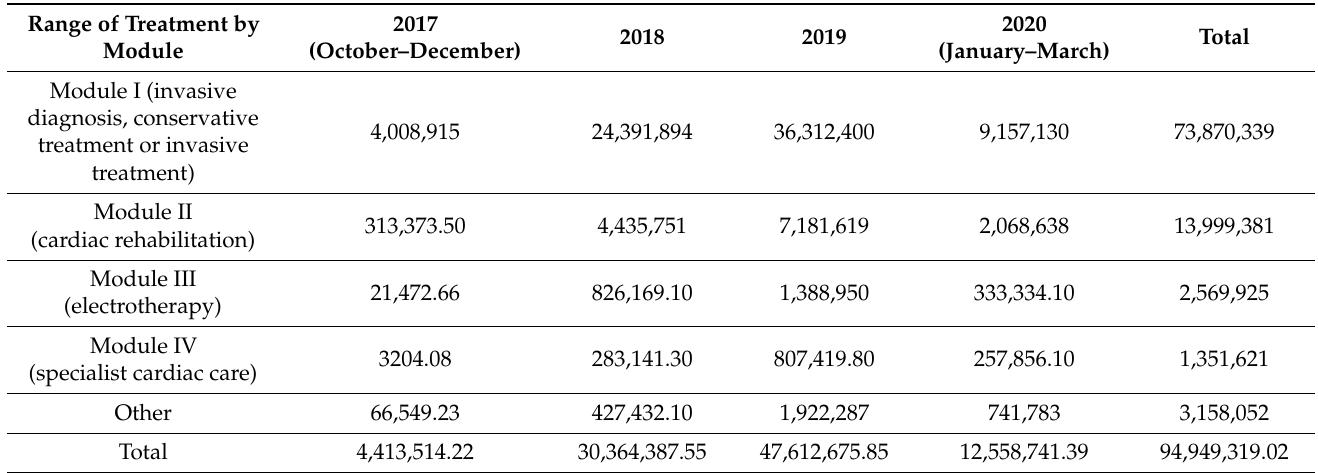
Table 3. Total costs of treatment (in EUR) of patients covered by CCMI.